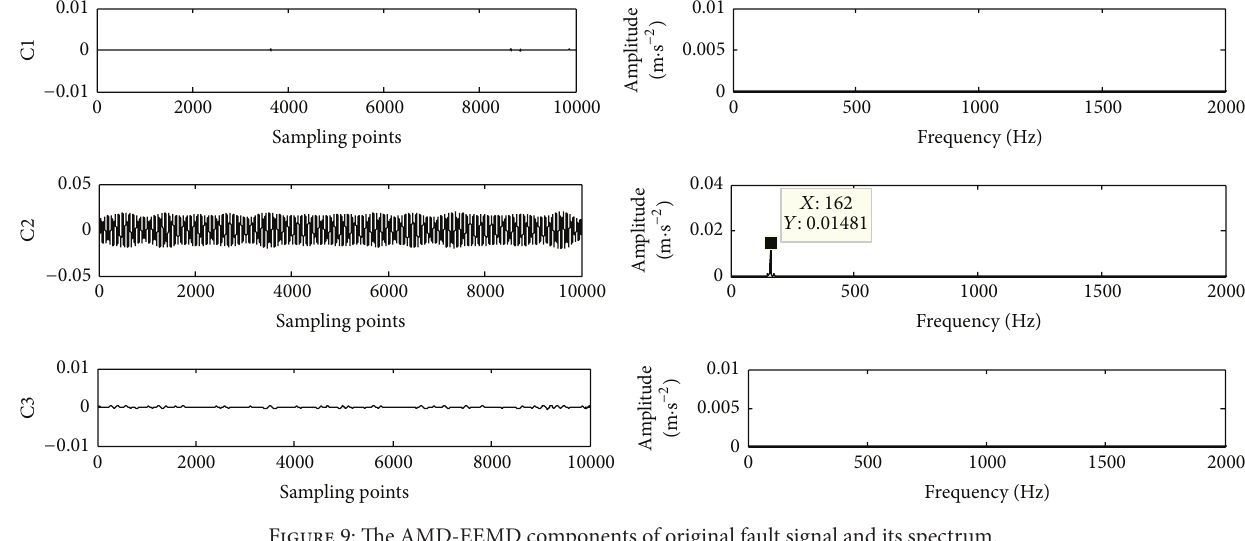
Figure 9: The AMD-EEMD components of original fault signal and its spectrum.